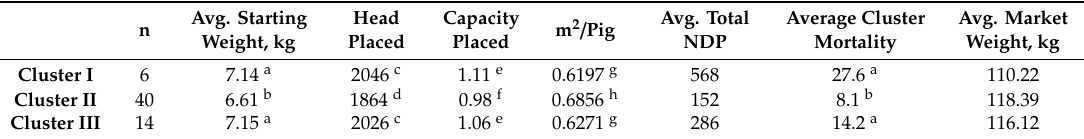
Table 10. Summary of management and performance data for each cluster. Average starting weight is the average pig weight at weaning upon placement into their WTF barn. Head placed is the average number of pigs placed per WTF barn, capacity place is a proportion based upon an expected number of head available to populate barn; m 2 / pig is the area per pig calculated from the pen dimensions in Table 1. Avg. total NDP is the average of all dead pigs for each cluster. Avg. market weight is the average sale weight for each pig within a